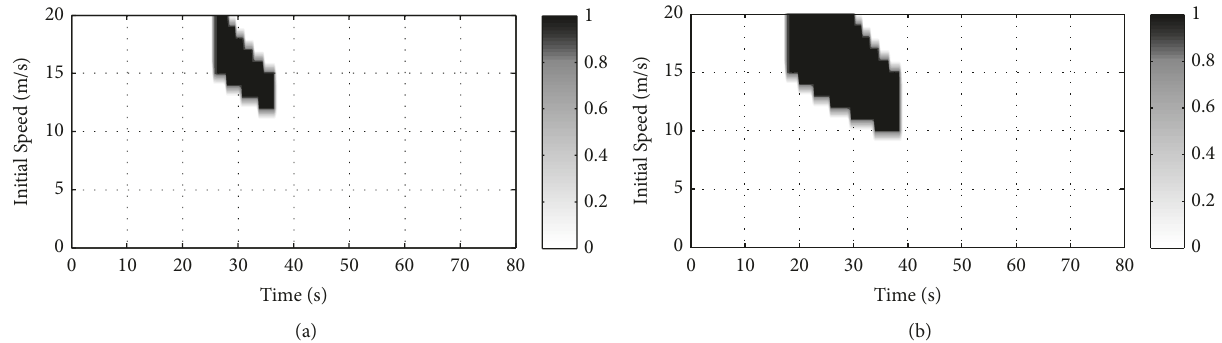
Figure 3: Study site.